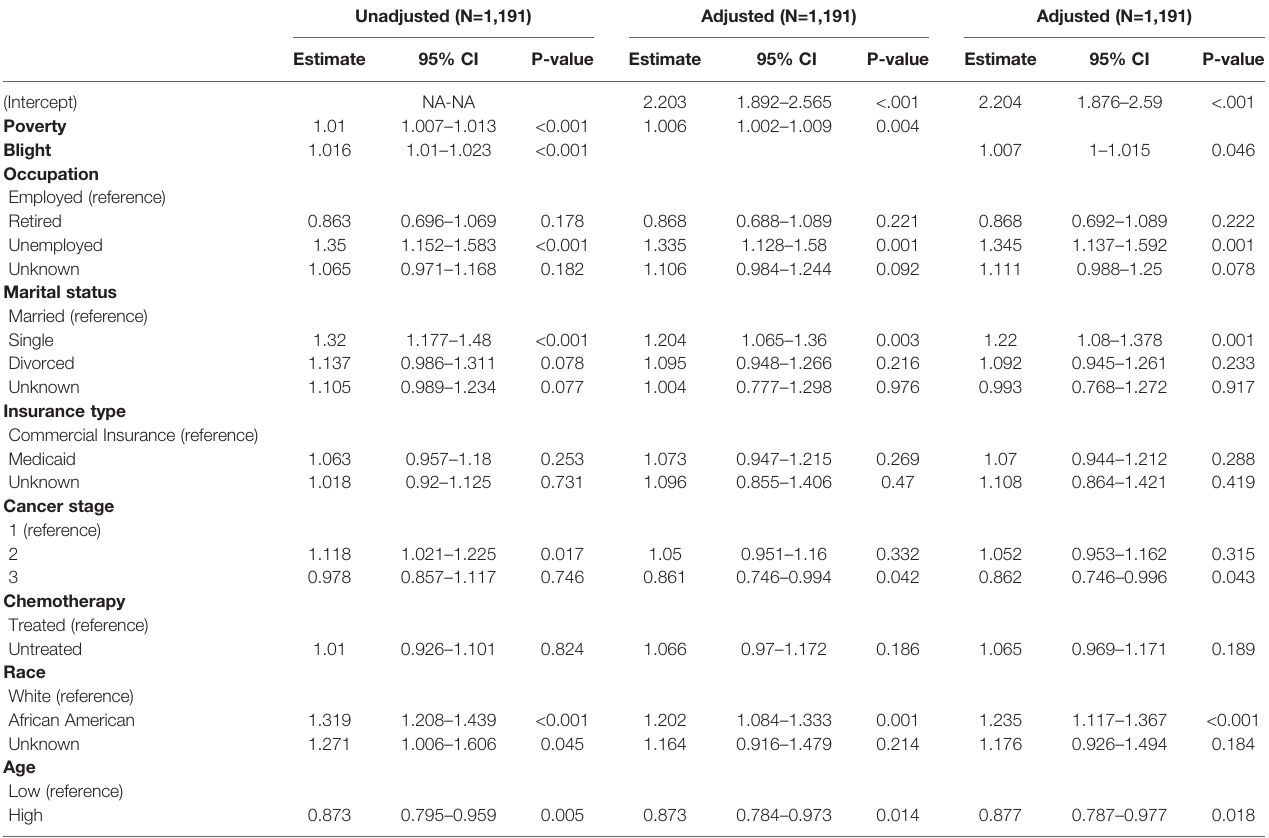
TABLE 3 | Count model: pain